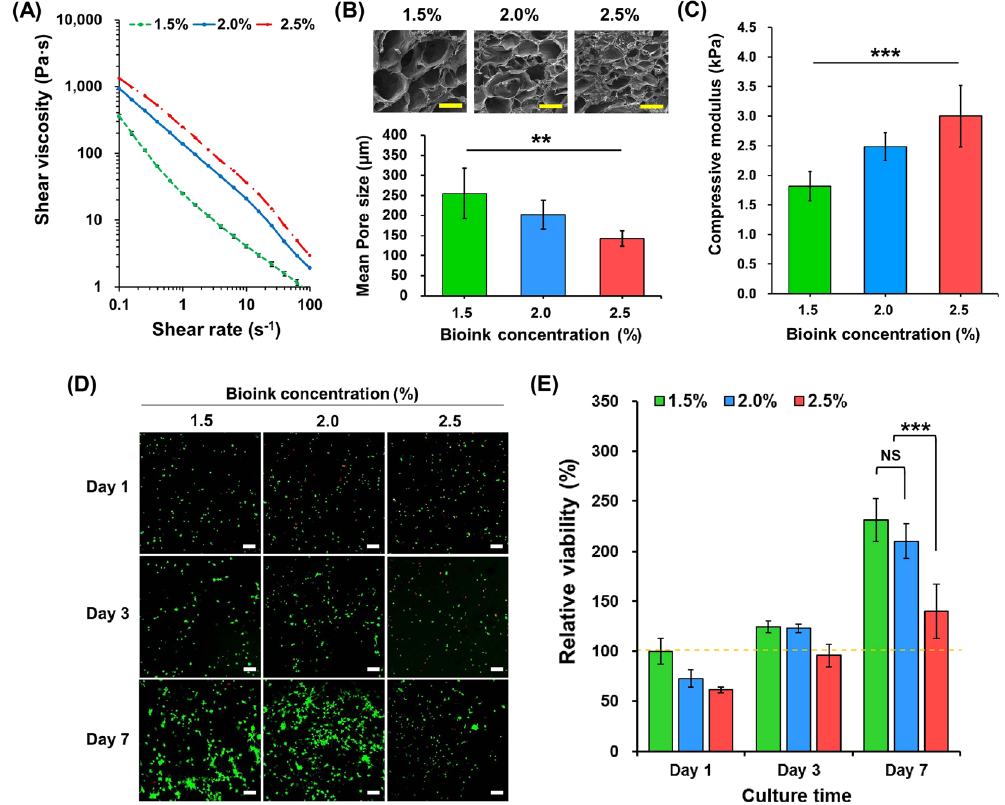
Figure 2. Analysis of dECM bioink with respect to physical and biological properties. ( A ) Shear viscosity, ( B ) SEM images and mean pore sizes (yellow scale bar: 500 μ m; ** p < 0.005), and ( C ) compressive moduli of bioinks with various concentrations ( *** p < 0.05). ( D ) Live/dead assay results of NIH3T3 cells within bioinks with various concentrations (1.5%, 2.0%, and 2.5%) for 7 days (white scale bar: 100 μ m). ( E ) Relative viability (%) results. ( *** p < 0.05, NS = no significant